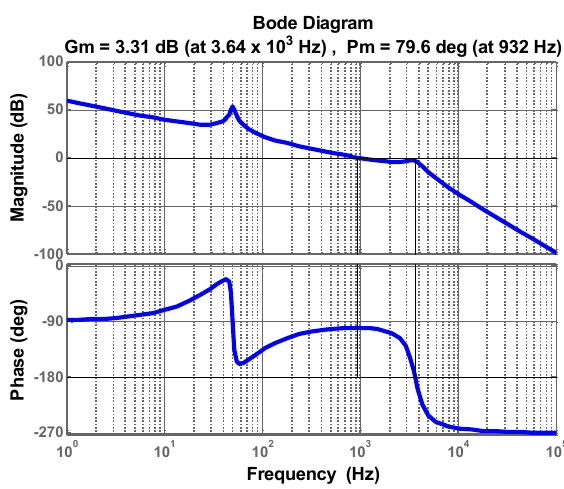
Figure 11. System Bode